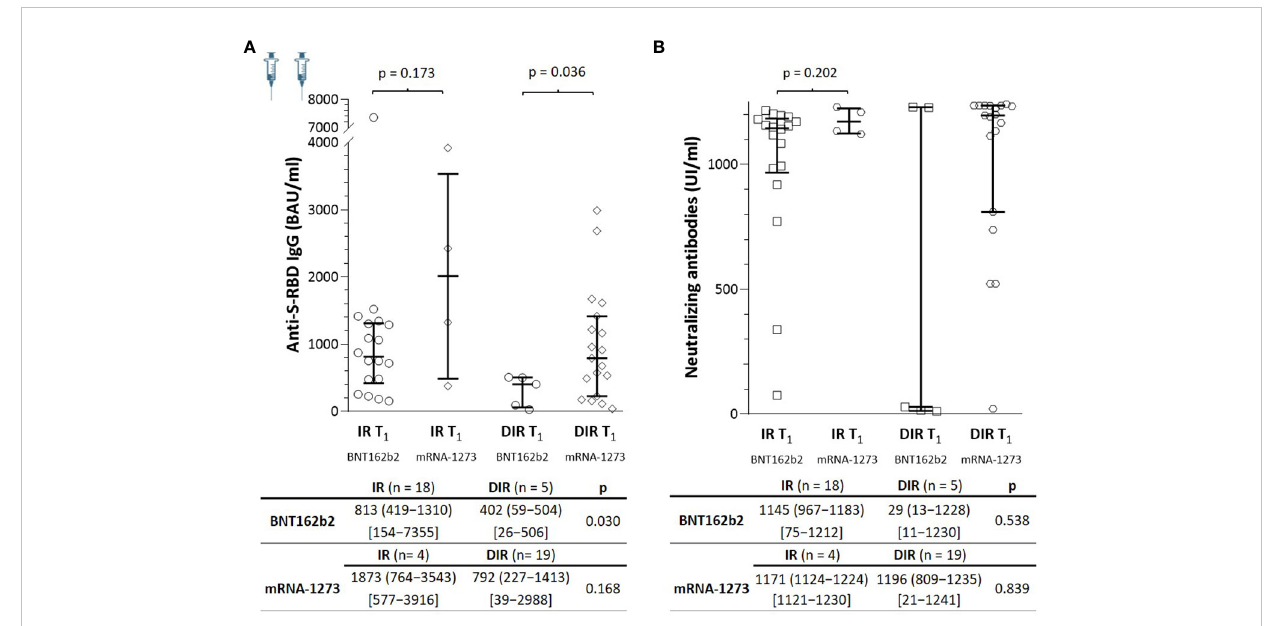
FIGURE 2 (A) Anti-S-RBD IgG and (B) neutralizing antibody titers one month (T1) after two mRNA vaccine doses according to the group of participants (IR, immune responders. DIR, discordant immune responders) and the vaccine